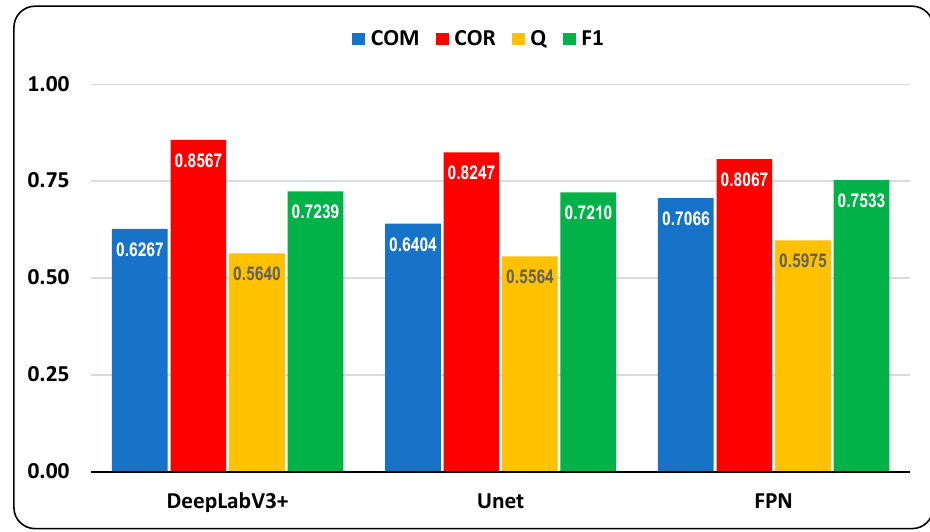
Figure 8. Rural road detection results over five sample input image tiles: ( a ) aerial images; ( b ) manually made ground truth masks; ( c ) images predicted by the DeepLabV3+ architecture; ( d ) images predicted by the Unet architecture; ( e ) images predicted by the FPN architecture.